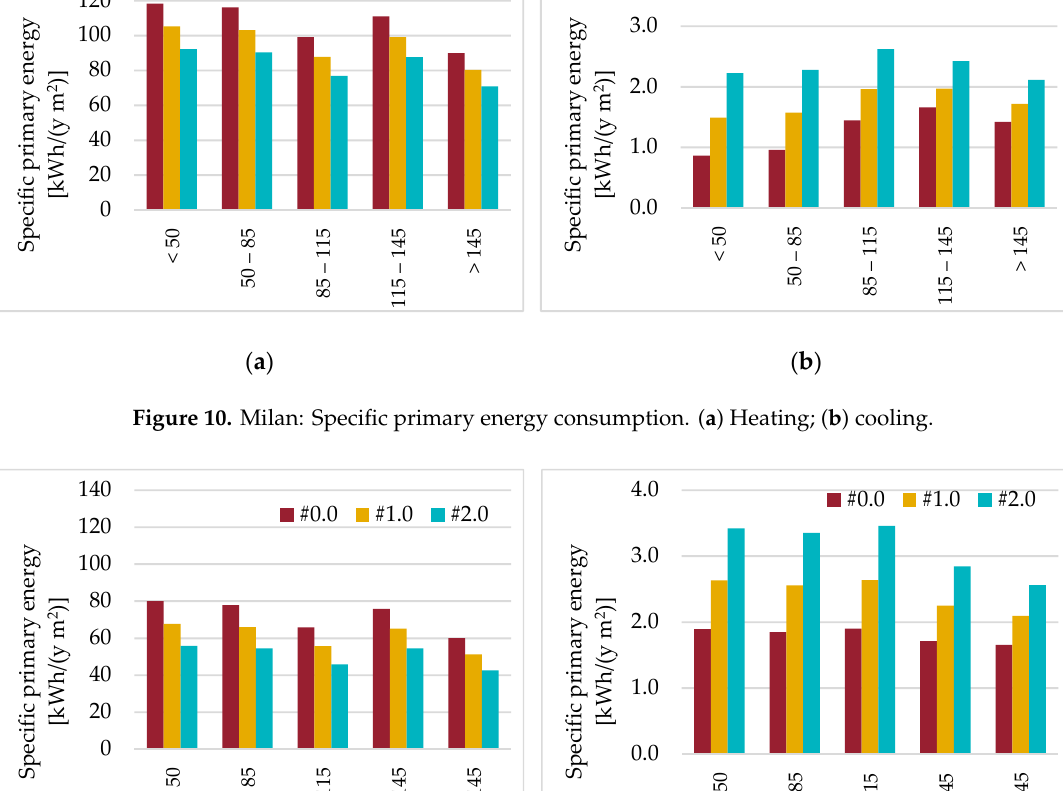
Figure 10. Milan: Specific primary energy consumption. ( a ) Heating; ( b ) cooling.